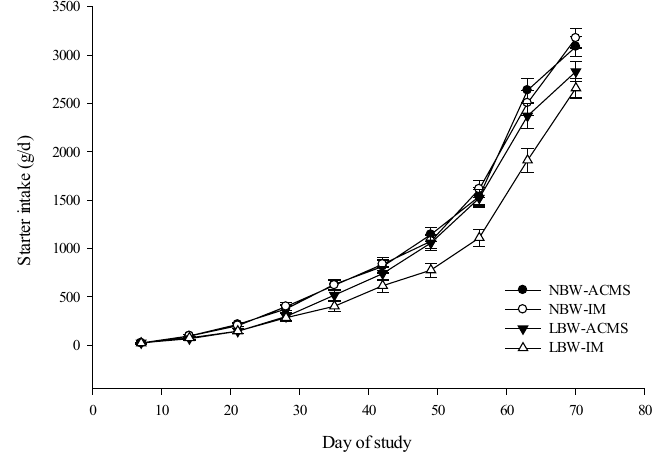
Figure 1. Mean starter feed intake (g/d) of calves with different birth body weights (n = 13 per treatment) fed diets with different mineral sources. Values are presented separately for normal birth weight calves fed diets containing an advanced chelated mineral source (NBW-ACMS; ● ), for normal birth weight calves fed diets containing an inorganic mineral source (NBW-IM; ○ ), for low birth weight calves fed diets that contained an advanced chelated mineral source (LBW-ACMS; ▼ ), and for low birth weight calves fed diets that contained an inorganic mineral source (LBW-IM; ∆) are presented. Data are presented as mean ±